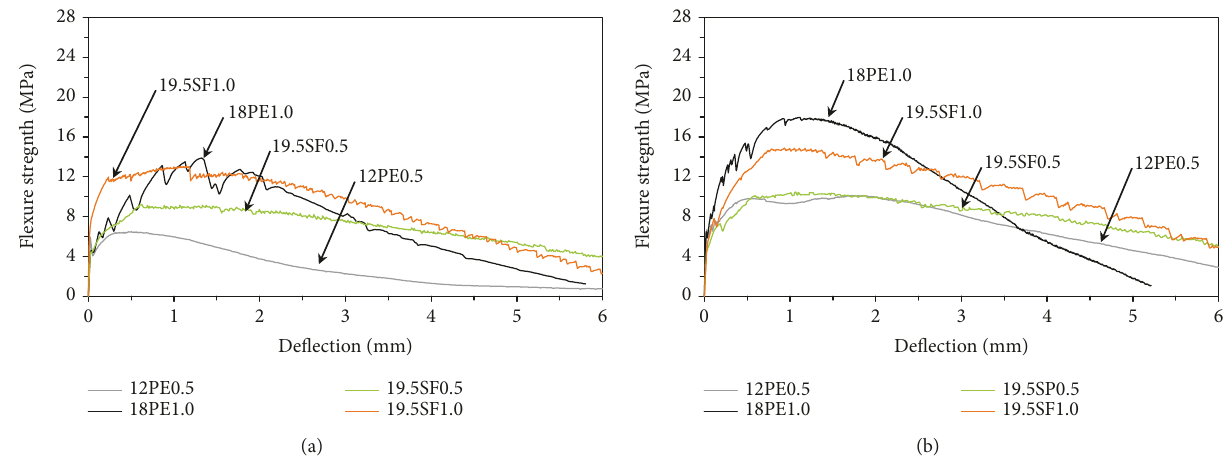
Figure 7: Average fl exure load-de fl ection behavior by individual fi bers: (a) various specimens of U16.4 and (b) various specimens of U17.2.